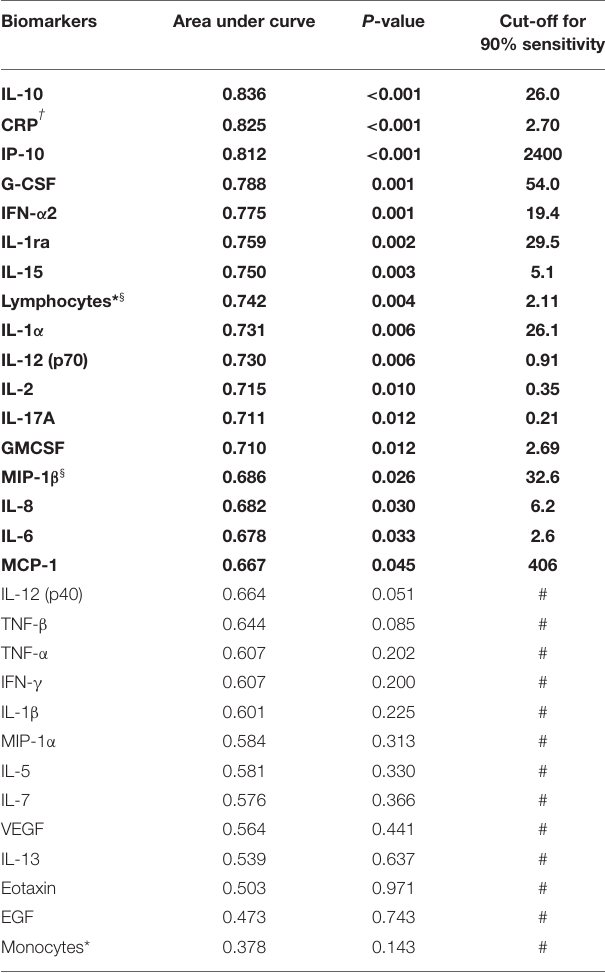
TABLE 4 | Forward stepwise logistic regression results for COVID-19 severity. Variables in the